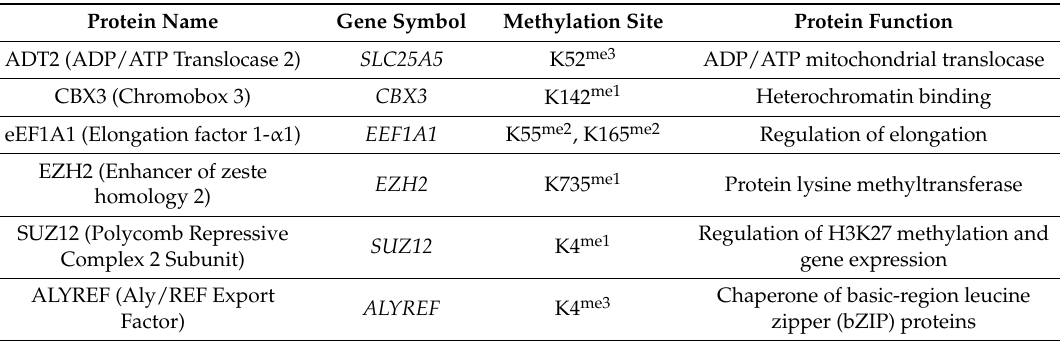
Table 4. Summary of potential non-histone EZH2 enzymatic